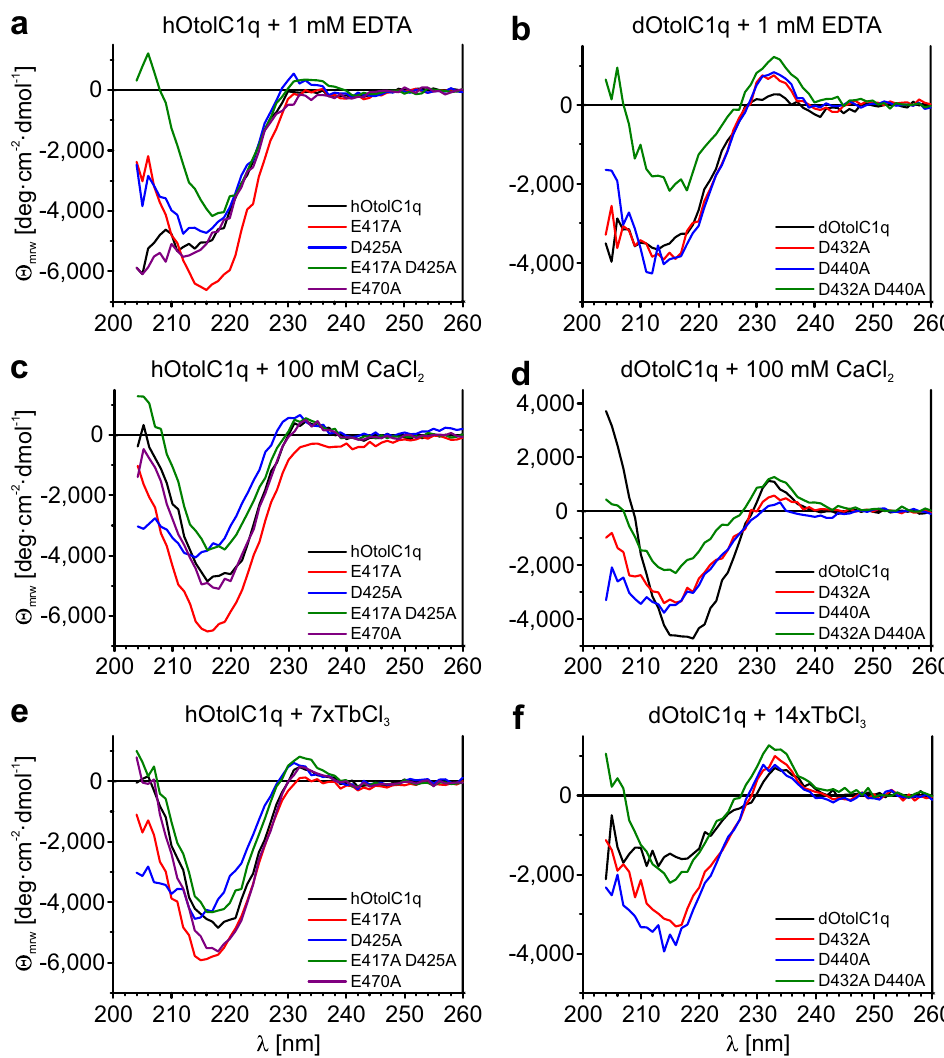
Figure 3. Changes in the secondary structure of hOtolC1q, dOtolC1q and their mutants caused by Ca 2+ and Tb 3+ . Circular dichroism (CD) spectra were obtained for ( a , c , e ) hOtolC1q, ( b , d , f ) dOtolC1q and their mutants in the presence of ( a , b ) 1 mM EDTA, ( c , d ) 10 mM CaCl 2 , ( e ) sevenfold molar excess of TbCl 3 or ( f ) 14-fold molar excess of TbCl 3 . The protein concentration was 0.2 mg/ml. The spectra are an average of 5 subsequent measurements and were corrected for the signal from a solvent. Θ mrw —mean residual ellipticity. See also Suppl. Fig.